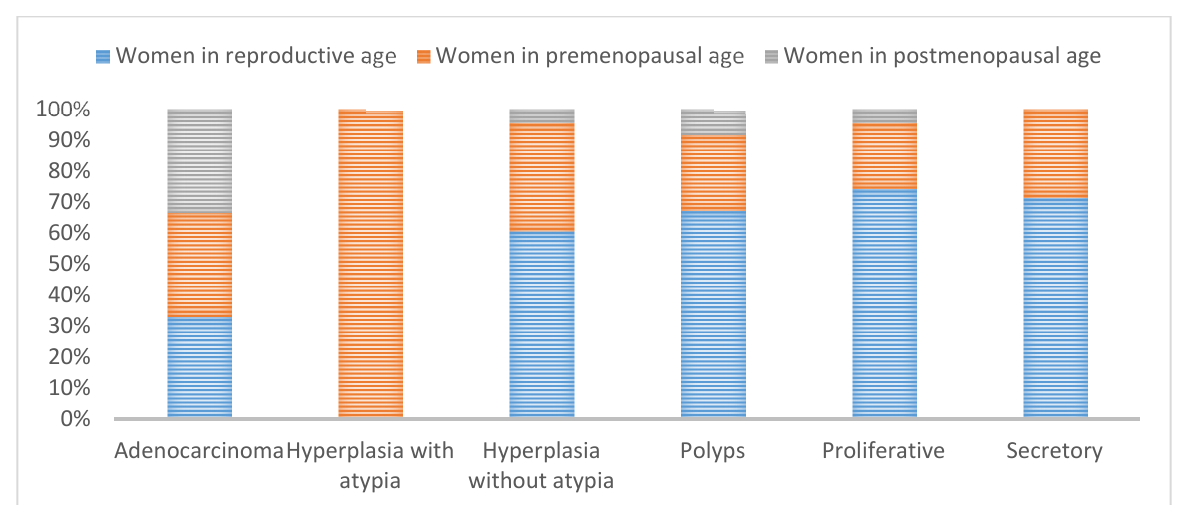
Figure 2. Results of histopathological diagnosis of endometrial samples by age group (D&C).